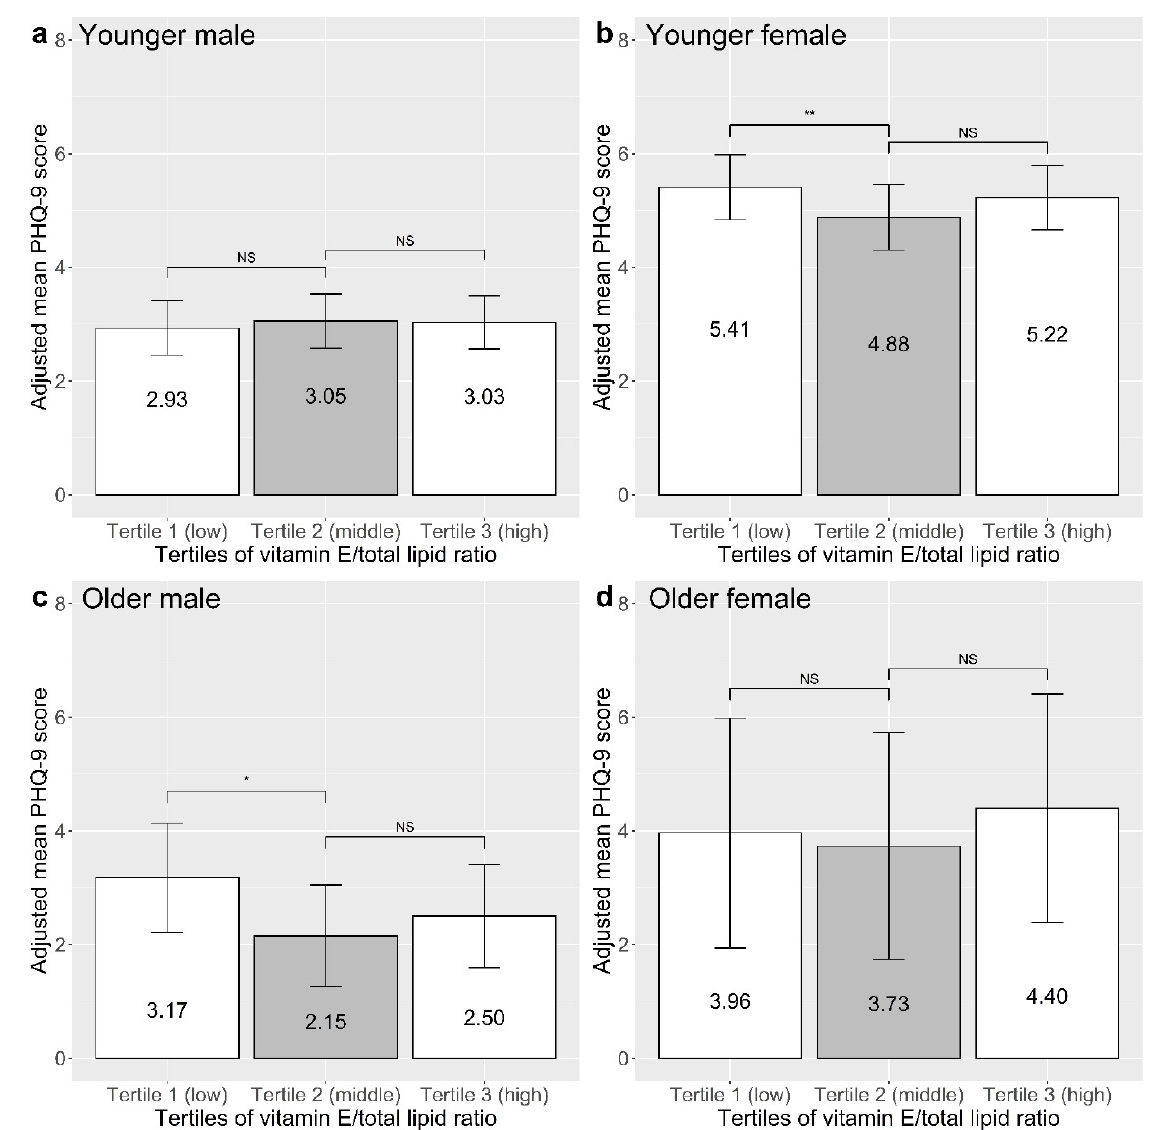
Figure 2. Levels of depressive symptoms by tertiles of vitamin E/total lipid ratio in ( a ) younger males, ( b ) younger females, ( c ) older males, and ( d ) older females. Mean PHQ-9 scores were adjusted for educational attainment level, equalized household income, residential area, living situation, alcohol use status, smoking status, number of chronic medical diseases, adequacy of physical activity, and BMI category. Group effects of Tertile 1 or 3 (white boxes) on PHQ-9 scores were examined via multivariable linear regression analyses. Tertile 2 (gray box) was set as the reference group for the analyses. Error bars indicate 95% confidence intervals. NS: not significant; * p < 0.05; ** p < 0.01. PHQ-9, Patient Health Questionnaire-9.